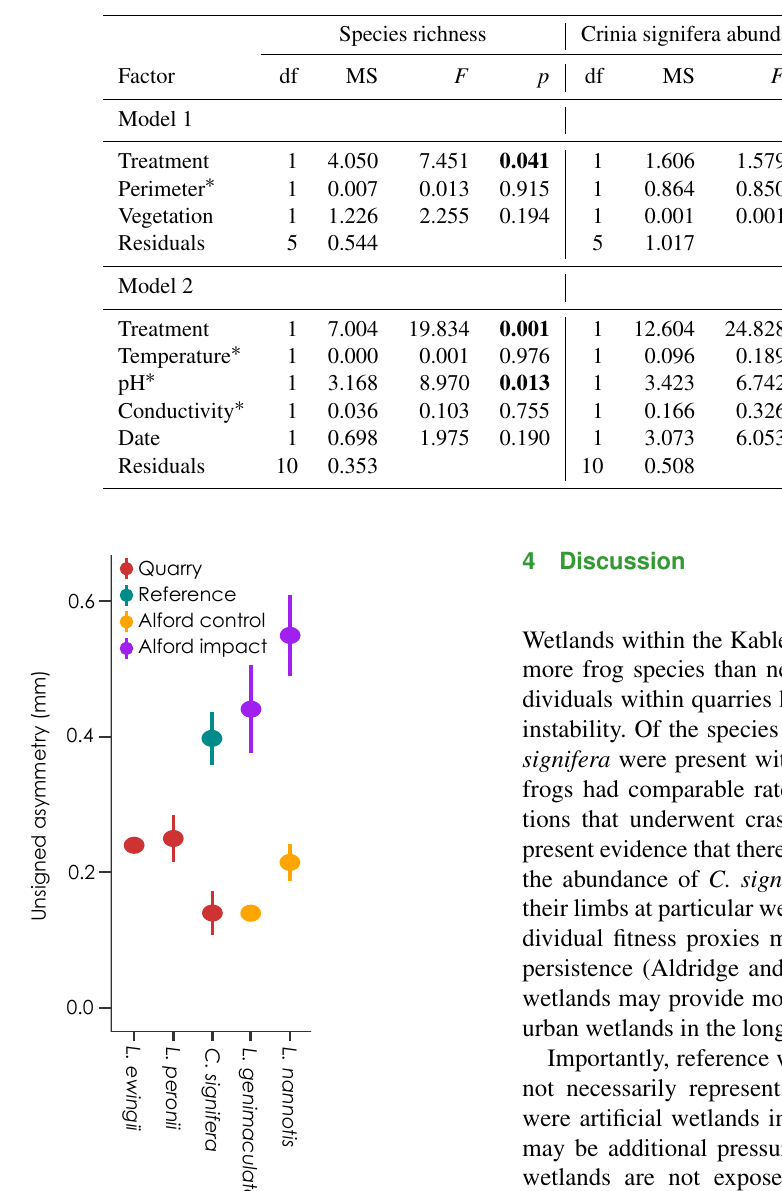
Table 2. Output from ANOVA for species richness and Crinia signifera abundance index with treatment (quarry or reference wetlands), wetland perimeter and vegetation (summed proportion of emergent and fringing vegetation) fitted as factors (Model 1). Treatment, water temperature, pH and conductivity, and date fitted as a blocking factor were included in Model 2. Asterisks indicate factors that were log- transformed to meet the assumptions of normality and homogeneity of variance. Boldface values represent significance at α = 0.05.